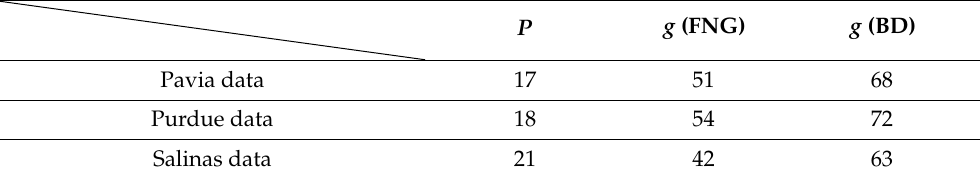
Table 2. The parameters of BG-SSRBSS used in the experiment.